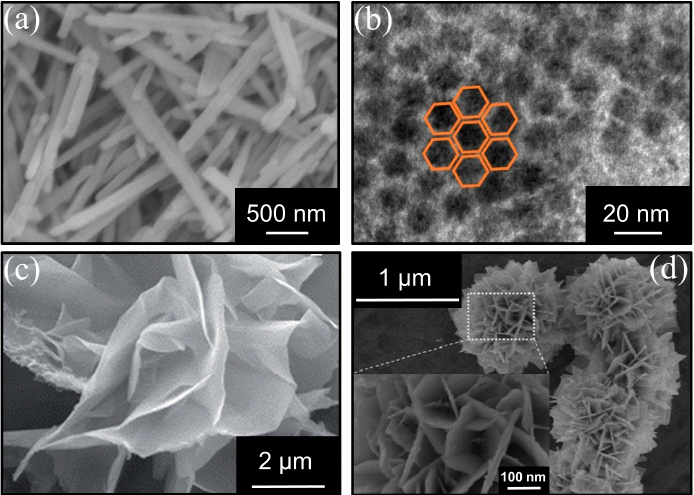
Figure 5. ( a ) SEM image of nanorod catalyst. Reprinted with permission: John Wiley and Sons, 2019 [59]; ( b )TEM image of nanotube catalyst. Reprinted with permission: John Wiley and Sons, 2019 [72]; ( c ) SEM image of nanosheet catalyst. Reprinted with permission: Royal Society of Chemistry, 2016 [64]; ( d ) FESEM image of flower-like Pt/SnOx. Reprinted with permission: Elsevier, 2017 [68].